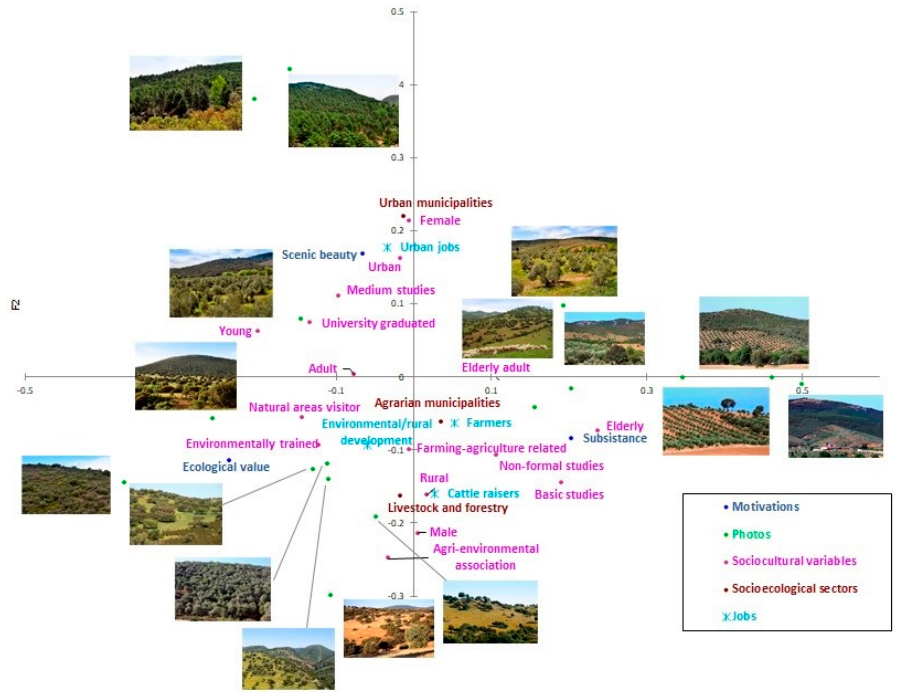
Figure 4. Biplot of redundancy analysis (RDA) results, including the images of the landscapes analyzed.